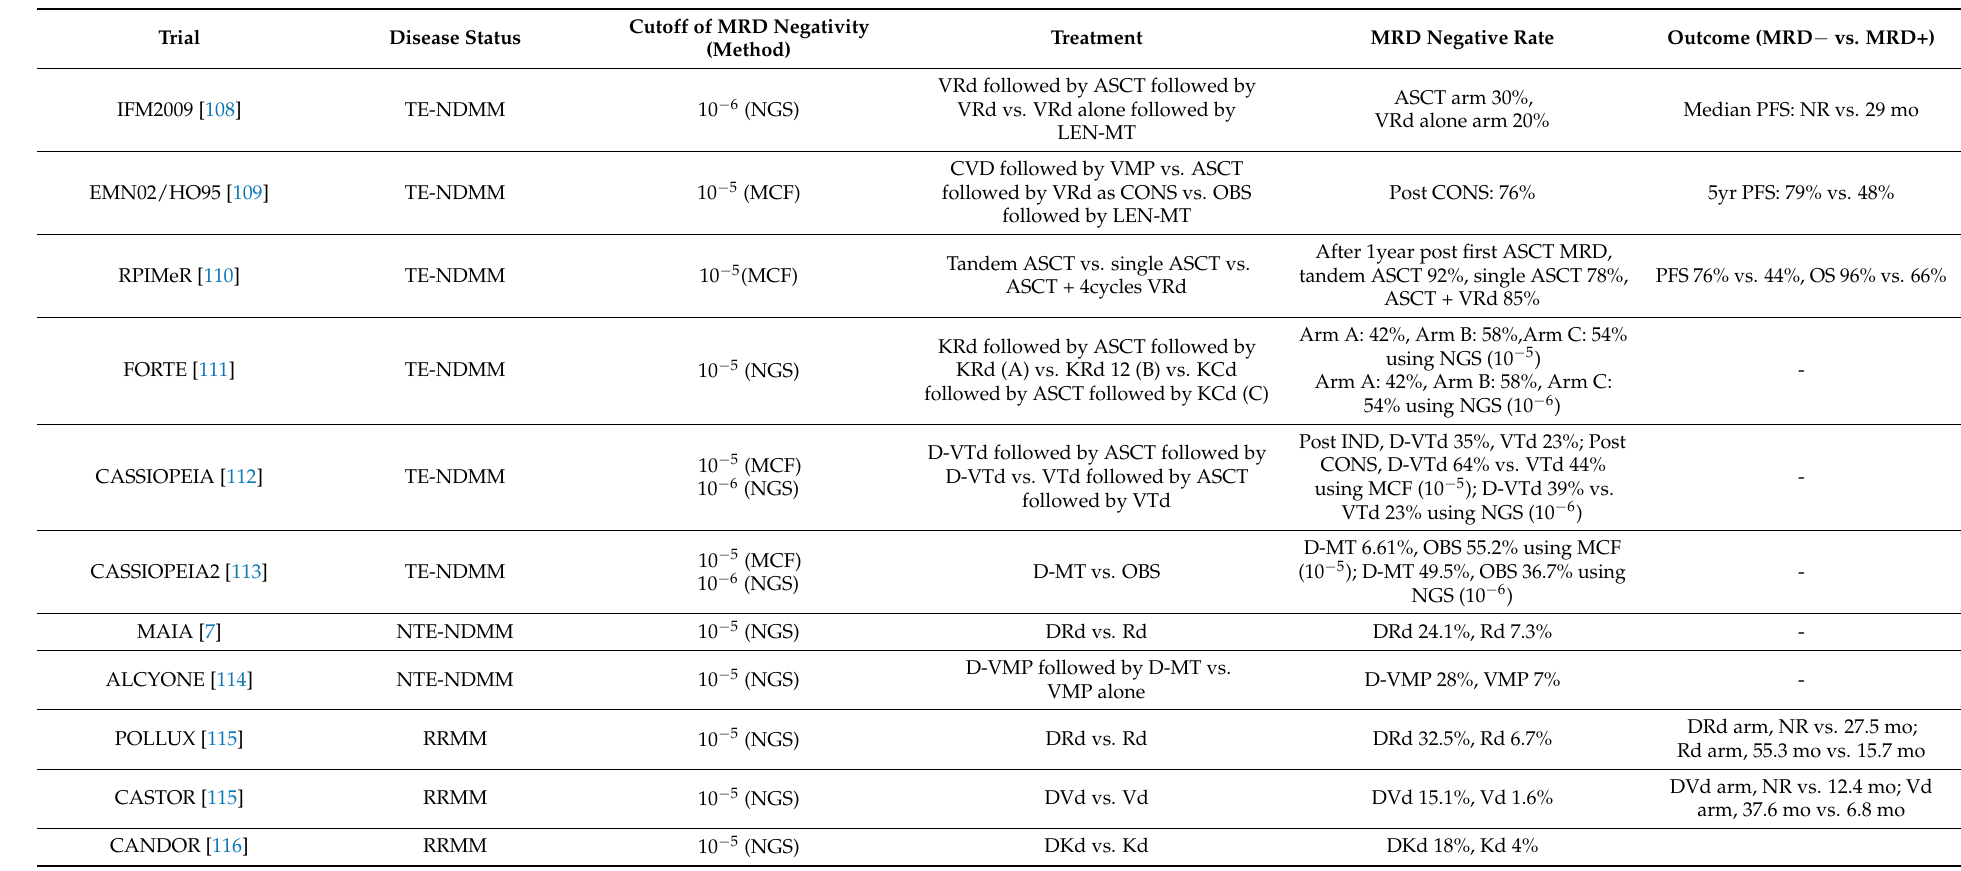
Table 2. Summary of phase 3 clinical trials investigating MRD status. MRD, minimal residual disease; TE-NDMM, transplantation eligible newly diagnosed multiple myeloma; NTE-NDMM, not transplantation eligible newly diagnosed multiple myeloma; RRMM, relapsed or refractory multiple myeloma; NGS, next generation sequencing; MCF, multi-color flowcytometry; DARA, daratumumab; LEN, lenalidomide; K, carfilzomib (CFZ); V, bortezomib (BOR); T, thalidomide (THAL); M, melphalan (MEL); C, cyclophosphamide (CPA);